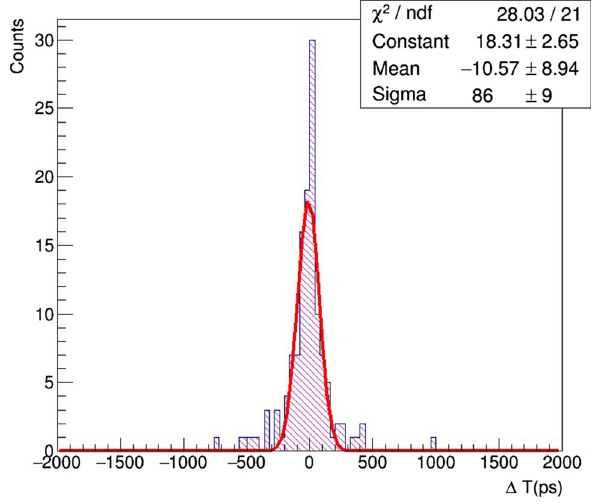
Fig. 13 MRPC time distribution relative to T 0 for a pion